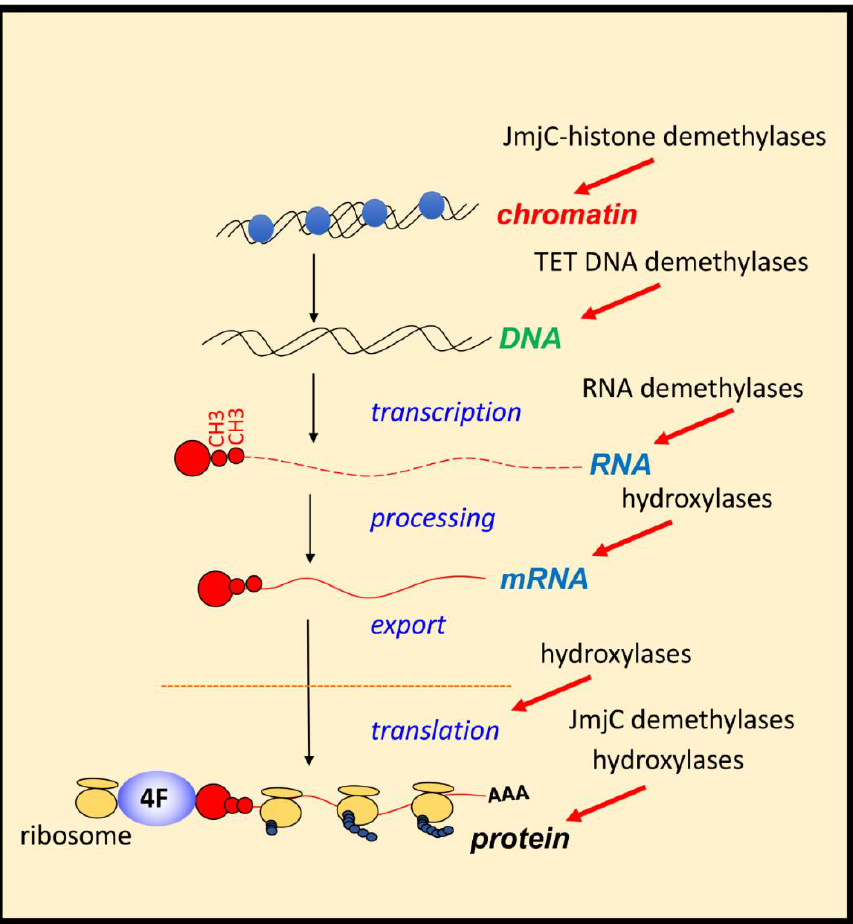
Figure 2. Control of gene expression by 2-ODGs in hypoxia. Hypoxia via the regulation of 2-OGDs has the potential of controlling all aspects of gene expression and protein function. Action of JmjC-histone demethylases and TETs (mediators of DNA demethylation) will impact on chromatin and DNA regulation. RNA demethylases, and several hydroxylases acts on mRNA processing, and fate. Hydroxylases also control rates of translation and ribosome activity, while JmjC-demethylases and hydroxylases can control protein function directly or indirectly by controlling other PTMs.